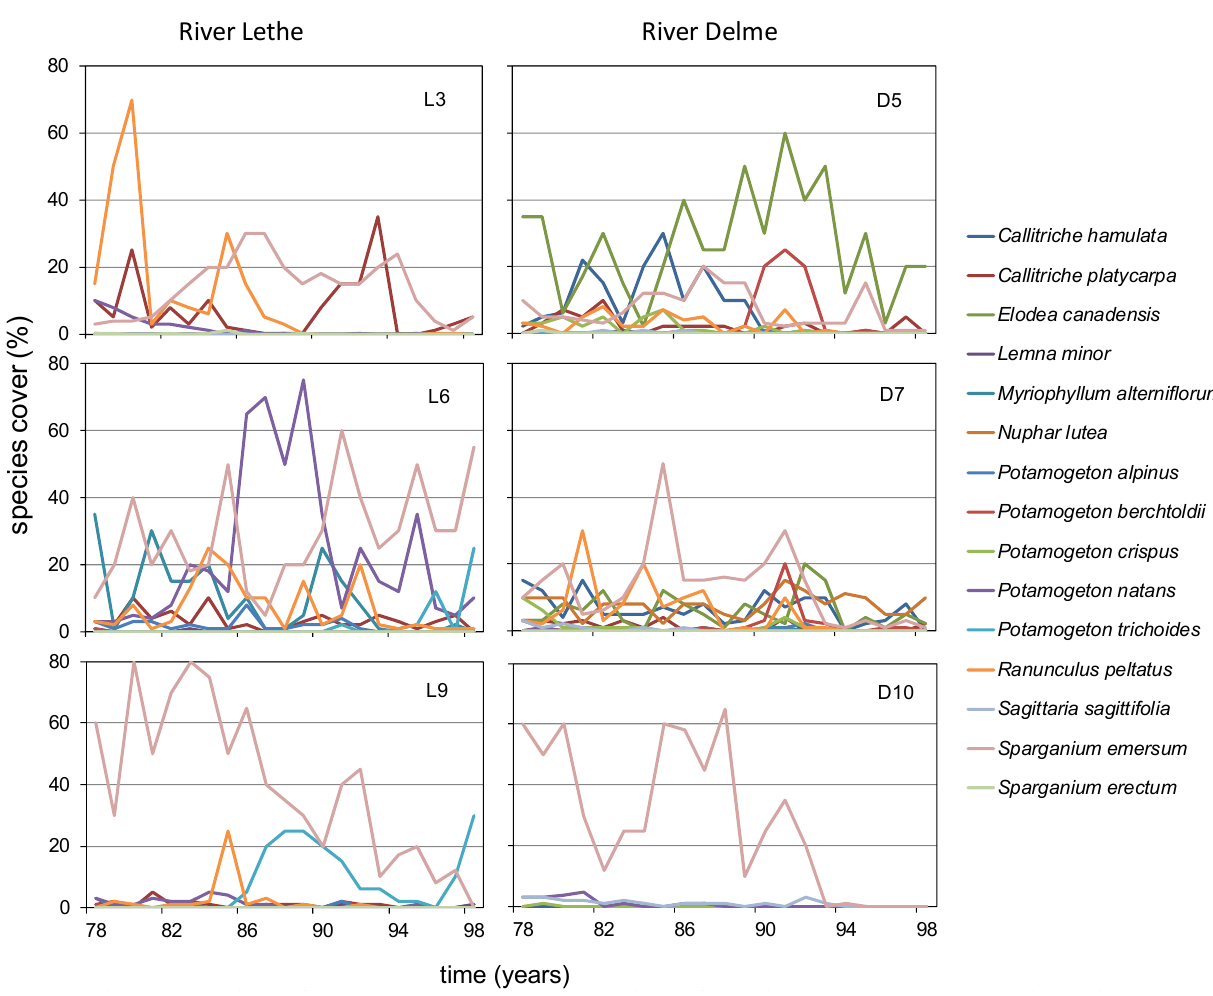
Figure 5. Temporal dynamics of the 15 most frequent hydrophyte species recorded in the rivers Lethe and Delme over 21 consecutive